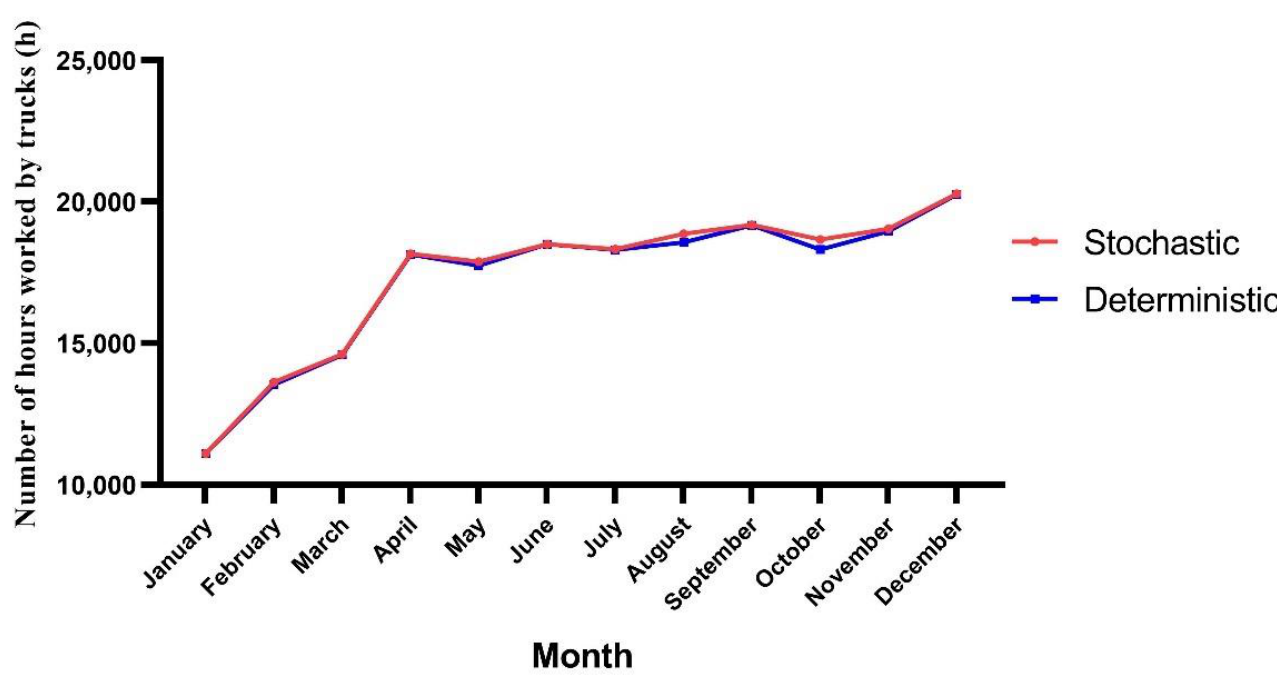
Figure 10. Number of hours worked by truck fleet in the deterministic and stochastic models.